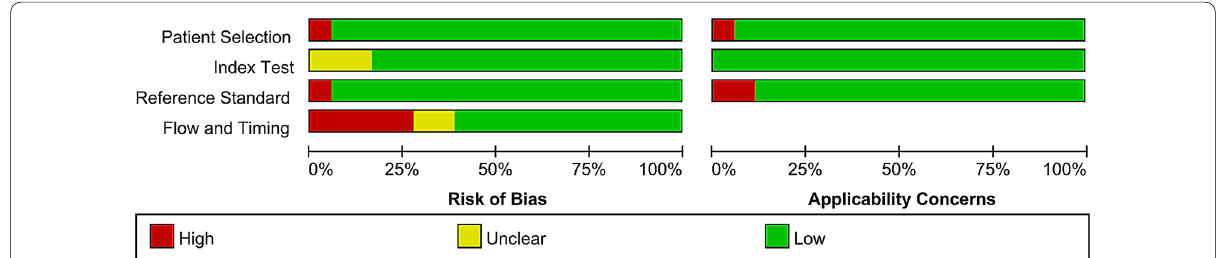
Fig. 2 Summary results of QUADAS tool on risk of bias and applicability concerns for the included studies in the present systematic